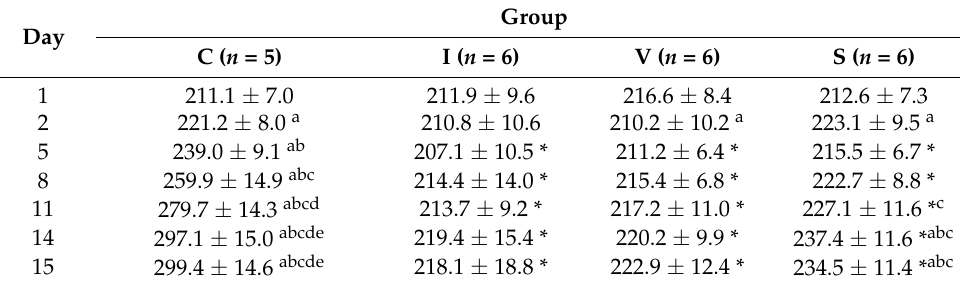
Table 1. Body weight (g) of rats in the control group and the three immobilization groups for 15 days. Group Day C ( n = 5) I ( n = 6) V ( n = 6) S ( n =